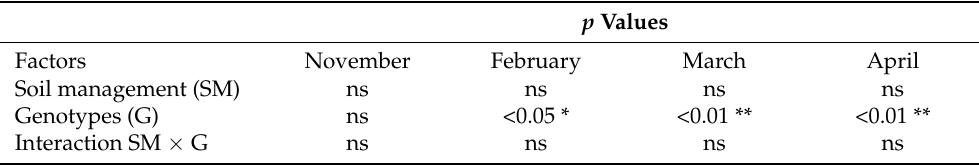
Table 5. Significance of the combined effects of soil management practices and genotypes on monthly estimated canopy of globe artichoke.